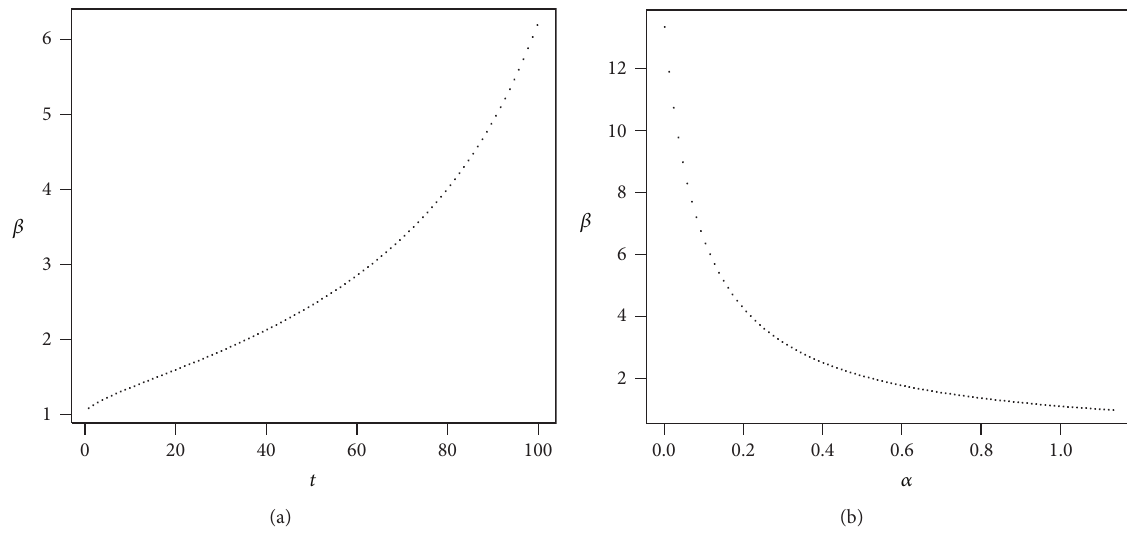
Figure 4: Low volatility of returns. The plot shows 𝛽 as a function of 𝑡 with 𝛼 = 50 % (a) and 𝛽 as a function of 𝛼 with 𝑡 = 40 (b). Parameters are 𝑟 = 4 %, 𝜇 = 7 %, 𝜎 = 16 %, ] = 0.1 %, and 𝛾 = 10